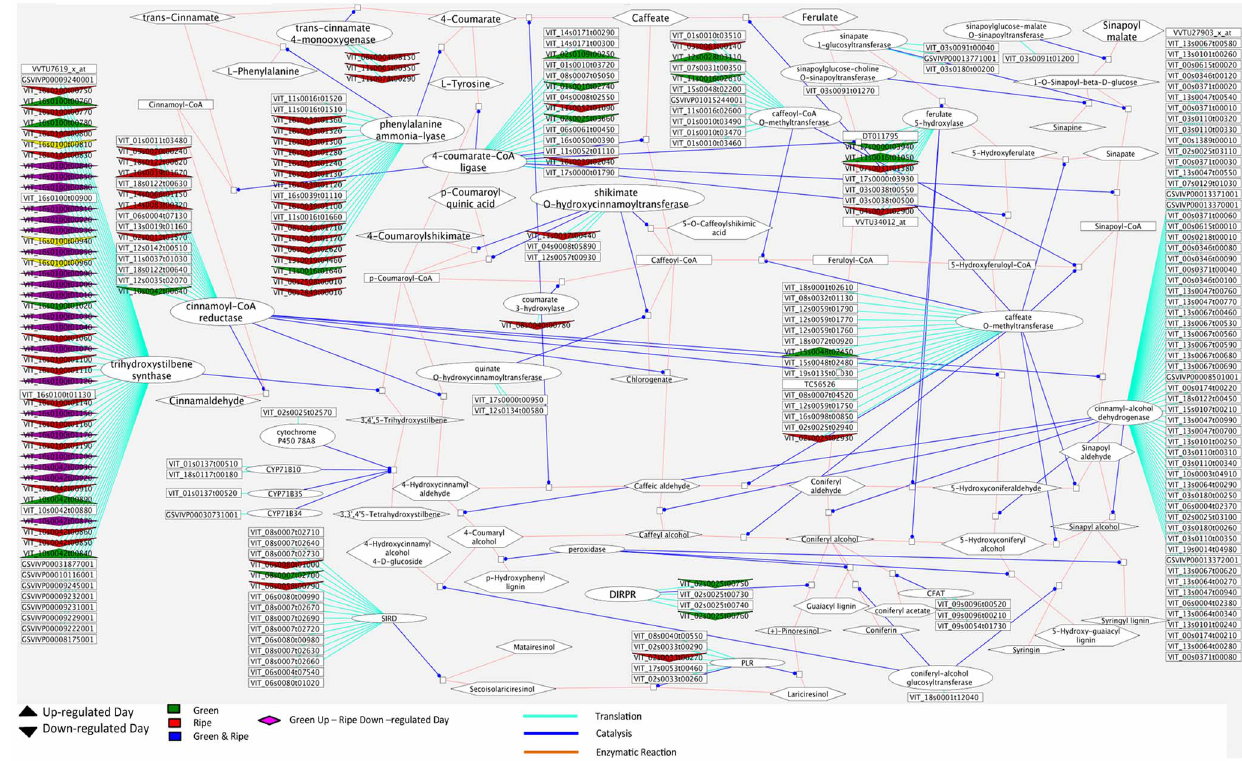
Figure 7. Cytoscape image of day/night modulated transcripts within the phenylpropanoid pathway. Only transcripts that were modulated at either, both green or both ripe stages (fold change . 2; pval adj , 0.05) are displayed. Arrow pointing upwards: up-regulated during the day (down-regulated at night); Arrow pointing downwards: down-regulated during the day (up-regulated at night). Green Arrow: Same regulation at G1 and G2; Red Arrow: Same regulation at R1 and R2; Purple Parallelogram: Day up-regulated in green stages; Day down-regulated in ripe stages; Magenta lines: Translation; Blue lines: Catalysis; Brown line: enzymatic reaction.